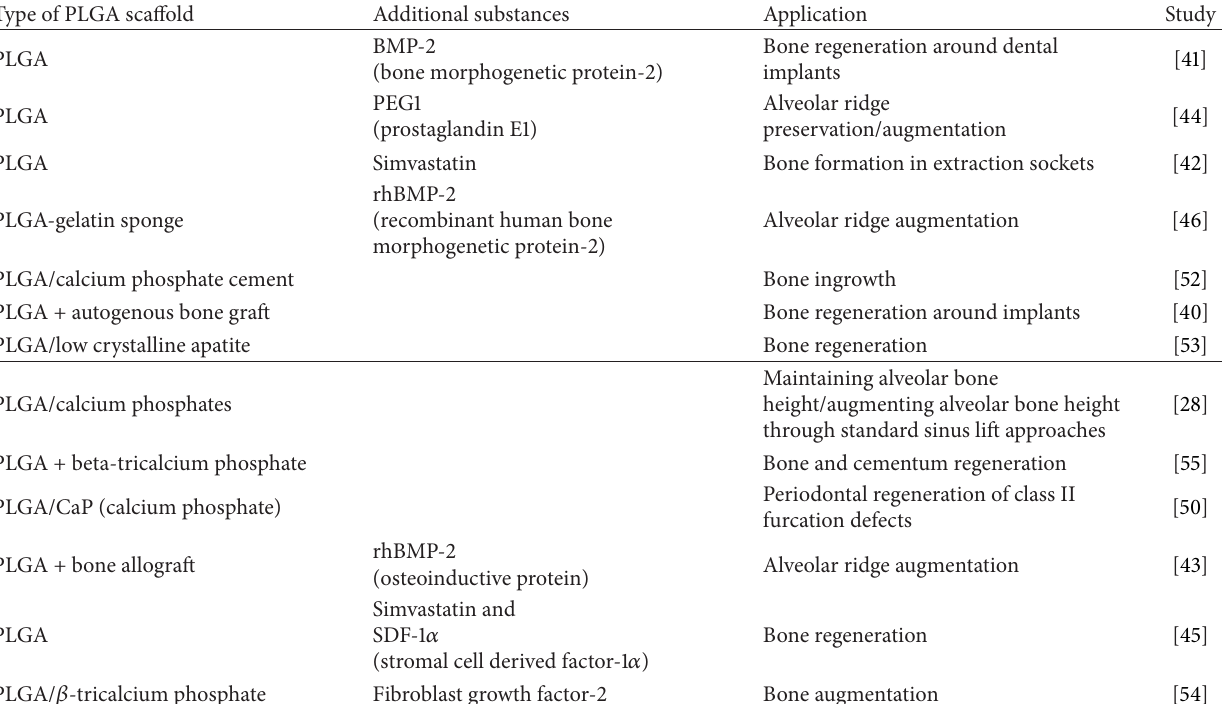
Table 2: Applications of PLGA scaffolds in